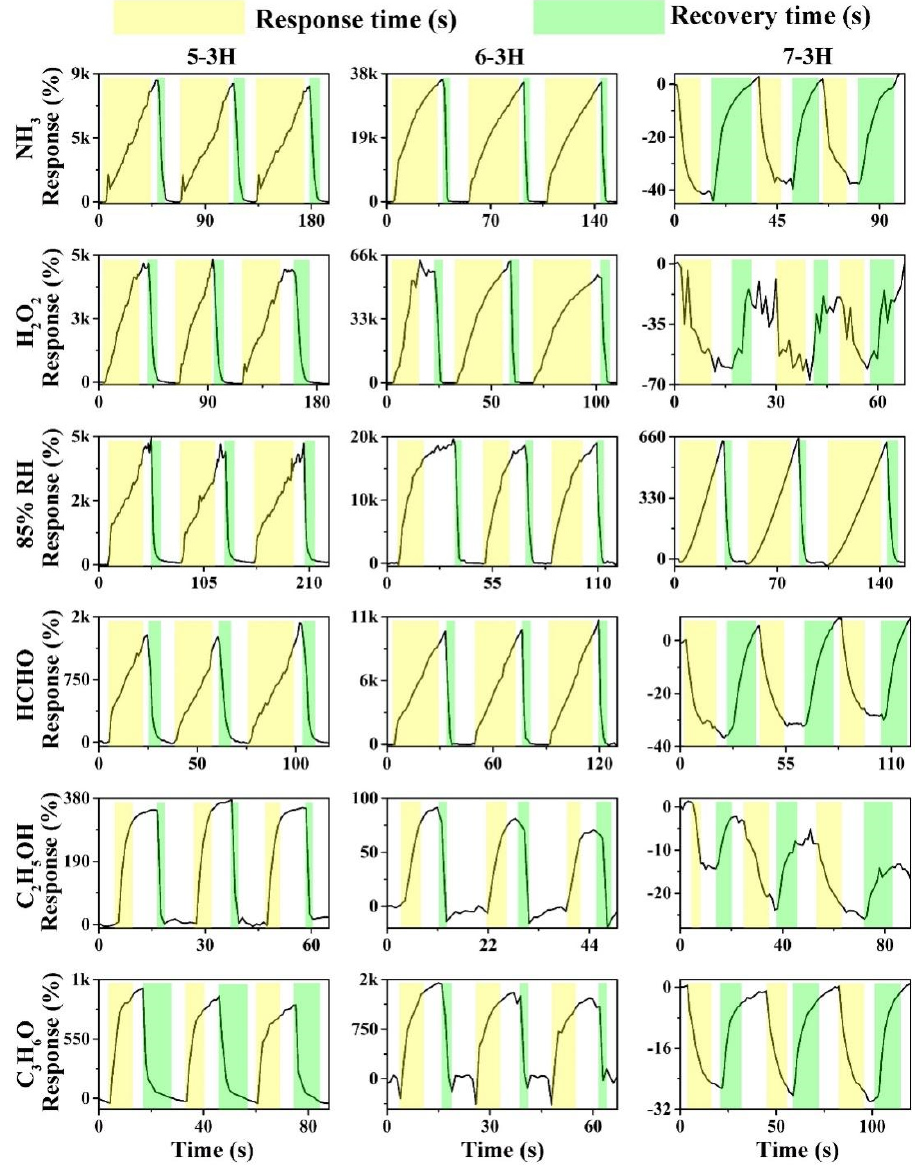
Figure 4. Dynamic sensing curves of the devices based on 5 − 3H, 6 − 3H, and 7 − 3H to 1000 ppm of NH 3 , H 2 O 2 , C 3 H 6 O, CH 2 O, and C 2 H 5 OH vapors and 85% RH at room temperature.